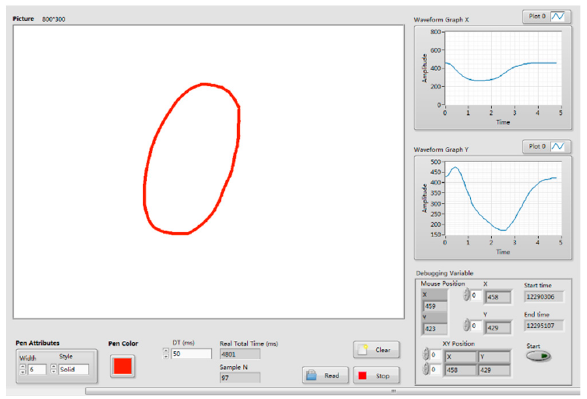
Figure 4. The Drawing Coordinates Acquisition System (DCAS) software developed in Labview.